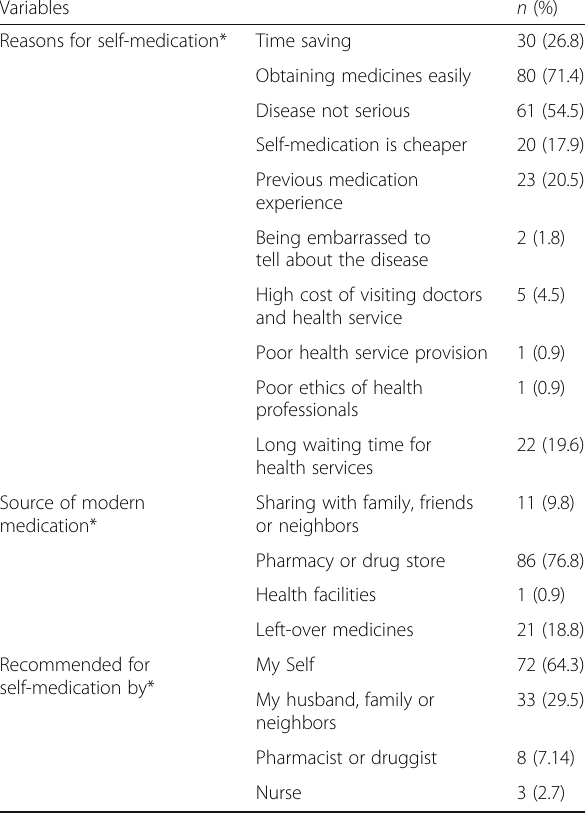
Table 3 Reasons for use, source of modern medication, and recommendation for self-medication of the pregnant women, Addis Ababa, 2017 ( n = 112)